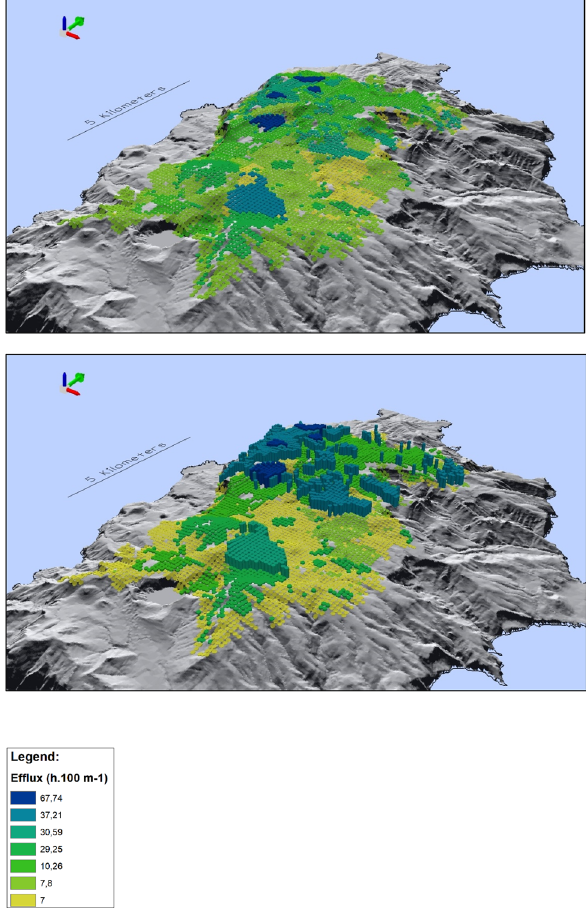
Fig. 11 Tridimensional representation of the efflux (h.100 m −1 ), actual (top) and potential (bottom), for Terceira Island Fig. 12 Tridimensional representation of the efflux (h.100 m −1 ), actual (top) and potential (bottom), for Flores